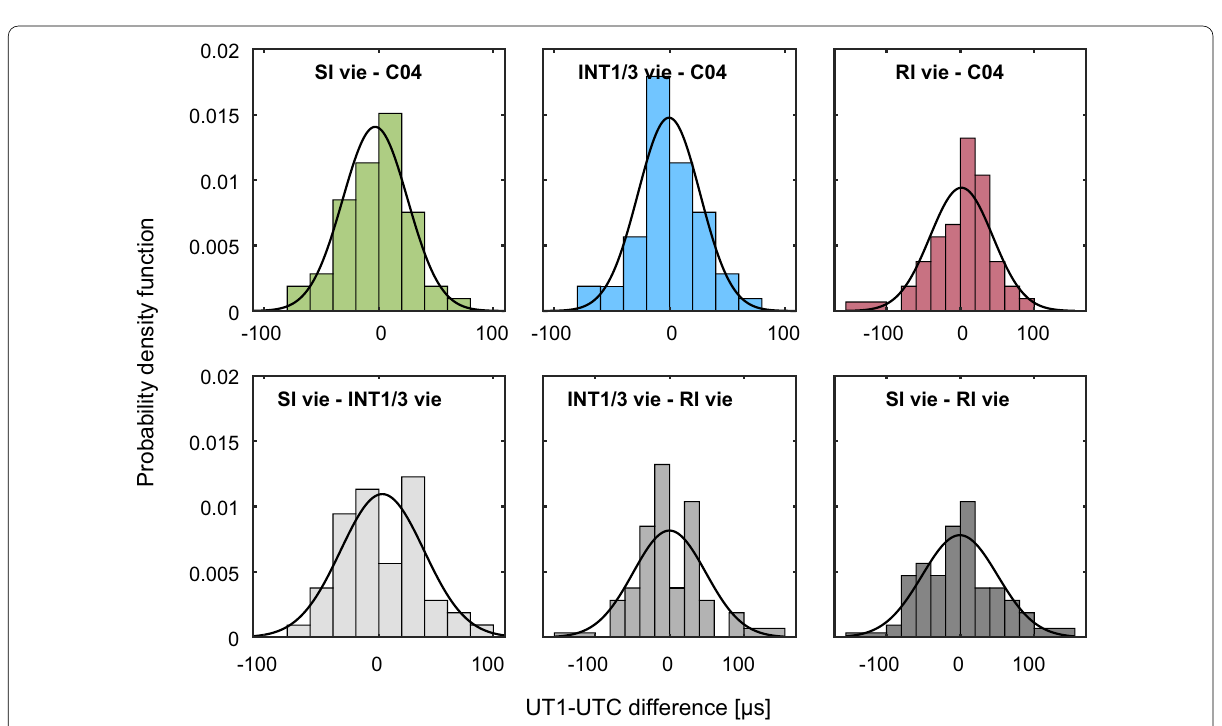
Fig. 7 Histograms of UT1 UTC differences [µs] with fitted normal distribution (solid black lines), normalised as probability density −